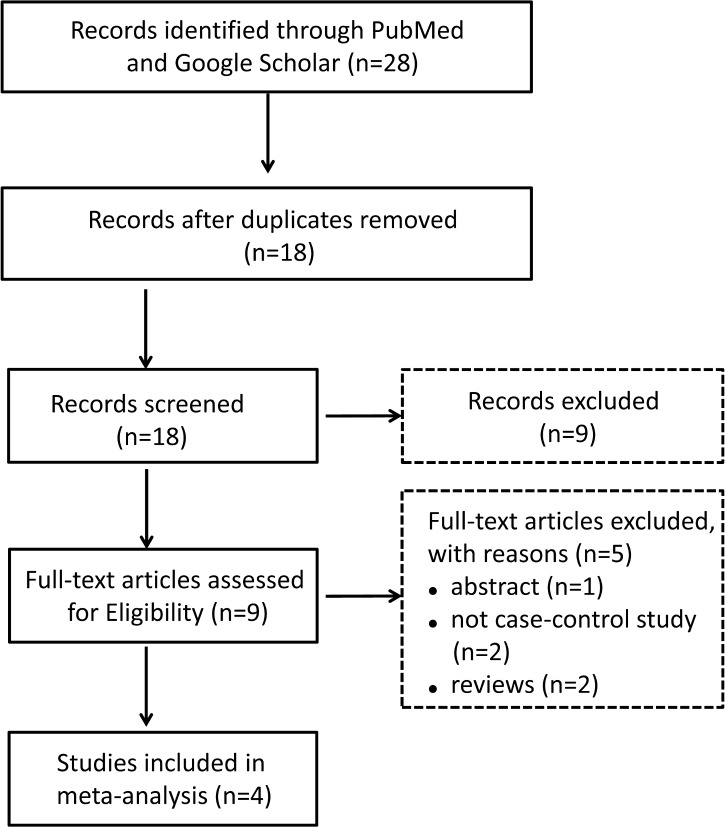
Flow chart of literature search and study selection.